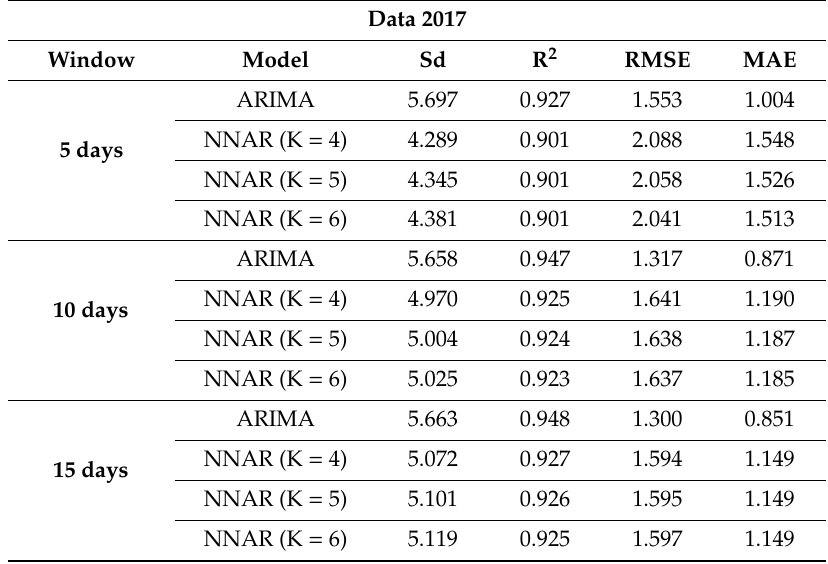
Table 1. Forecasting results using data from 2017: Standard deviation, determination coe ffi cient, root mean square error and mean absolute error for ARIMA and ANN.